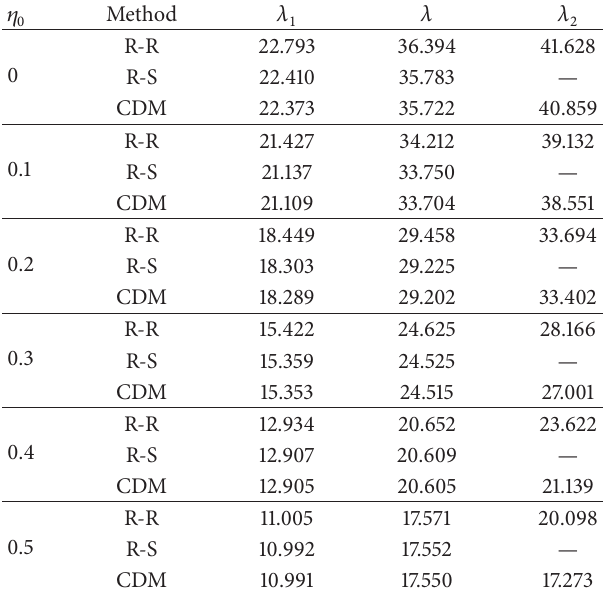
Table 3: Numerical comparison among R-R, R-S, and CDM of clamped-clamped DWCNTs: in columns 3 and 5, the first two dimensionless fundamental frequencies 𝜆 1 and 𝜆 2 , with 𝑐 12 = 0 , are reported, while in column 4 the first frequency 𝜆 , with = 0.0694 TPa, is listed. 𝑐 12